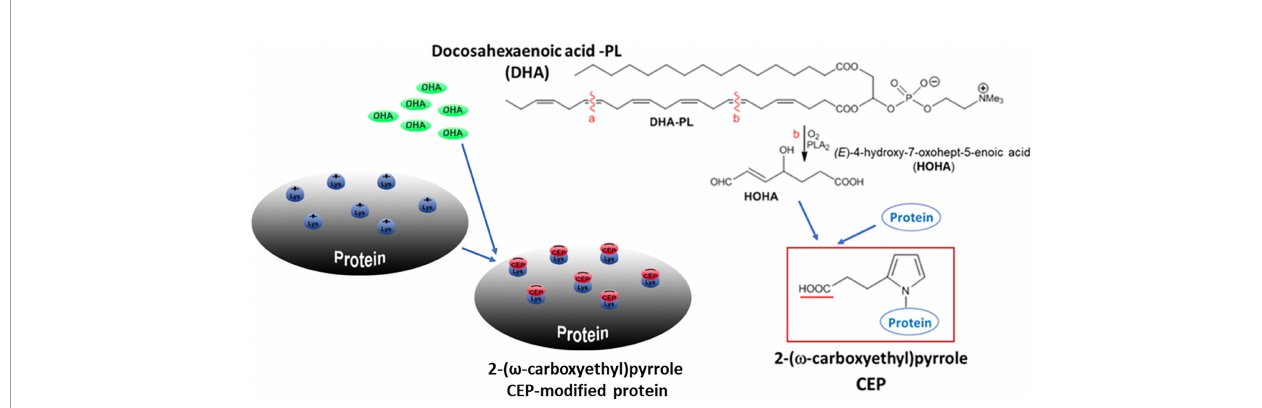
FIGURE 1 | Schematic representation of CEP formation. PLA 2 -catalyzed hydrolysis of DHA generates 4-hydroxy-7-oxo-hept-5-eonate (HOHA), which, in turn, produces 2- w -Carboxyethylpyrrole (CEP)-protein derivatives through condensation with the primary amino groups of protein lysyl residues. A positively charged lysine is modi fi ed by pyrrole with a negatively charged carboxyl group. Multiple lysines can be modi fi ed by CEP in one